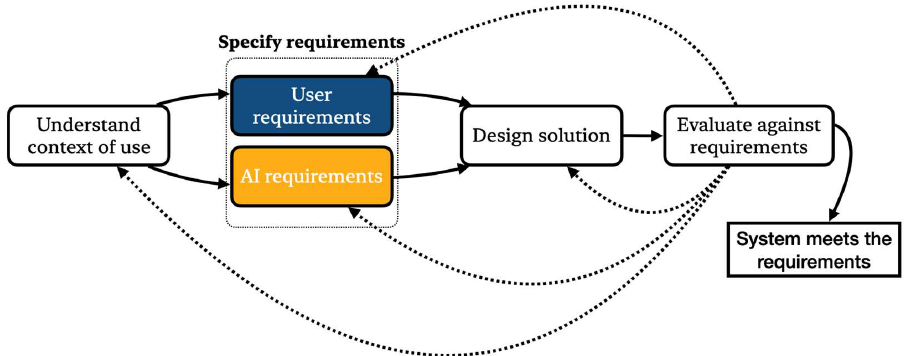
Figure 3. Intelligence-Centered Design (ICD) extends the traditional Human-Centered Design pro- cess to incorporate AI requirements at the same level as users’ requirements. Elaborated from